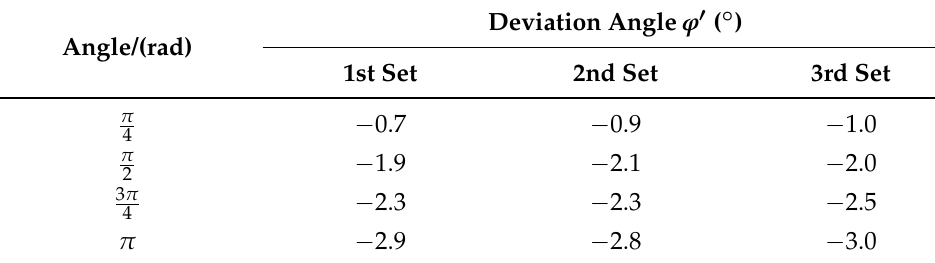
Table 6. Results of turning experiment in legged mode.